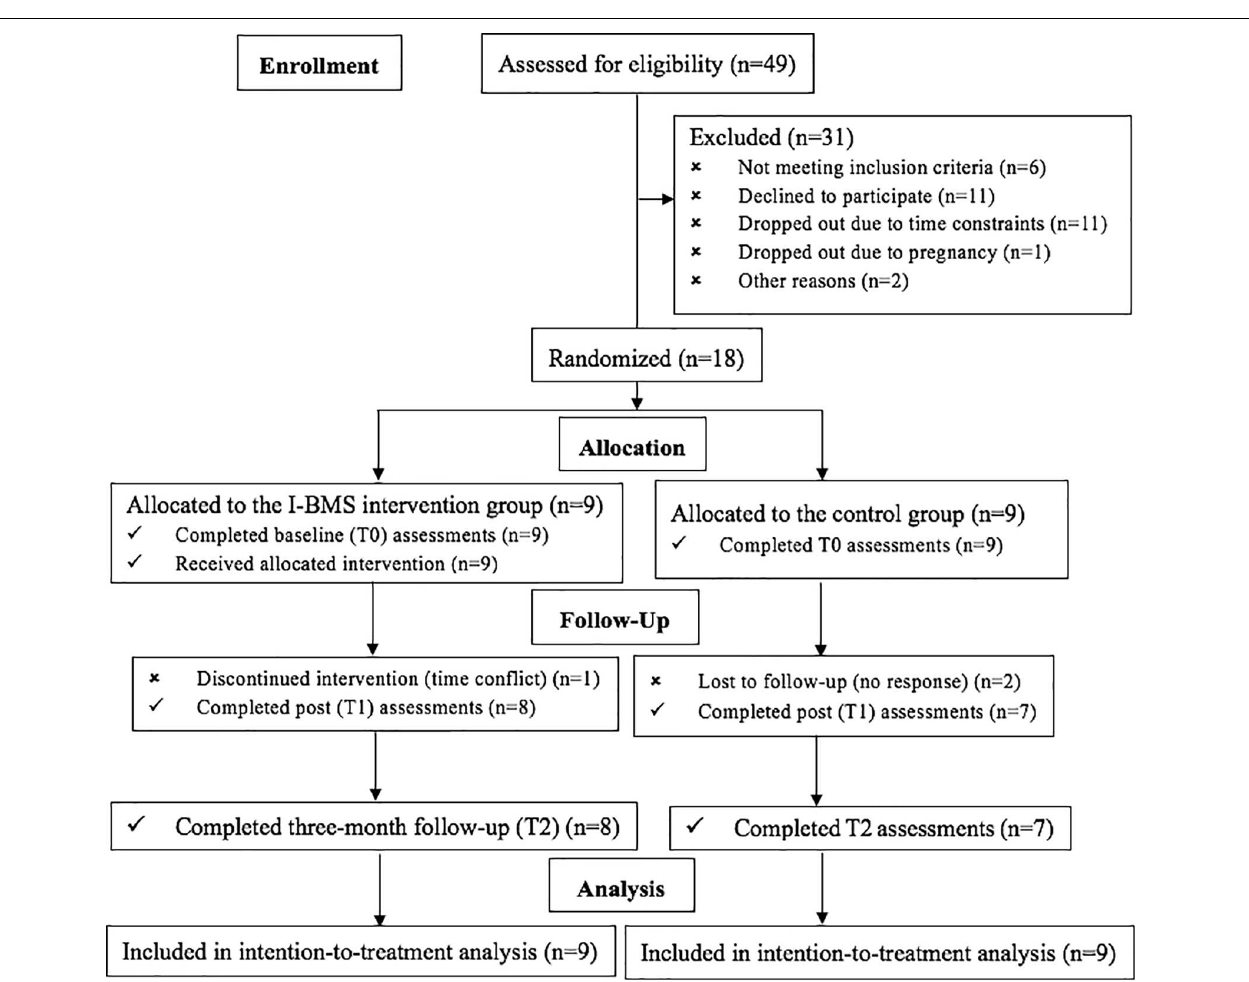
FIGURE 1 | CONSORT diagram of participant